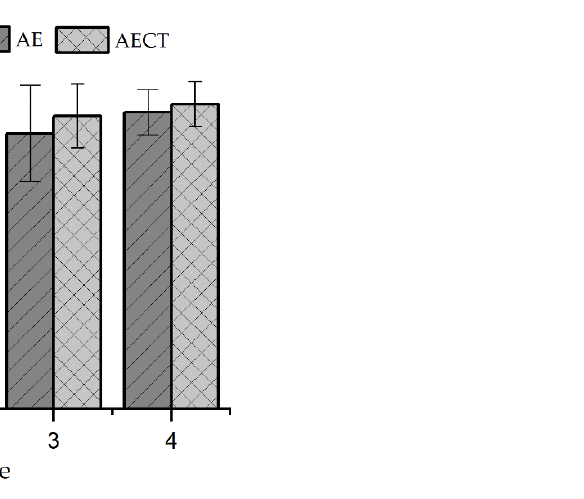
Figure 8. Surface roughness in AE and AECT samples. ( 1 ) AECT-1, ( 2 ) AECT-2, ( 3 ) AECT-3, ( 4 ) AECT-4.